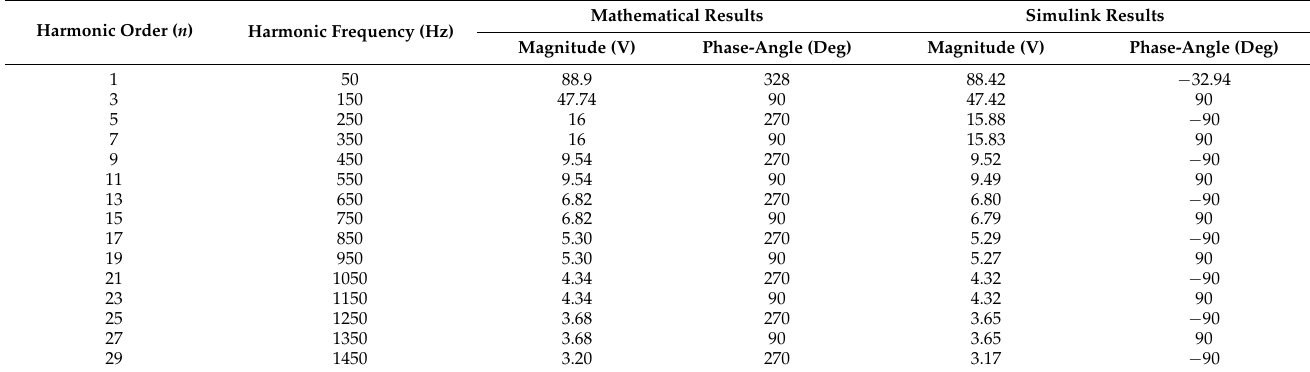
Table 3. Harmonic coefficients of output bipolar voltage control with a phase-angle of π /2.